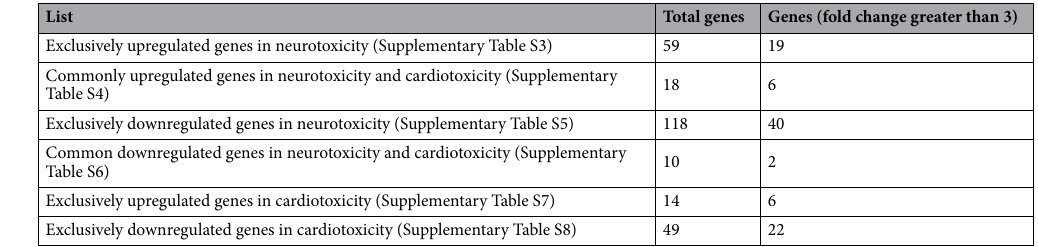
Table 2. Numbers of genes in each